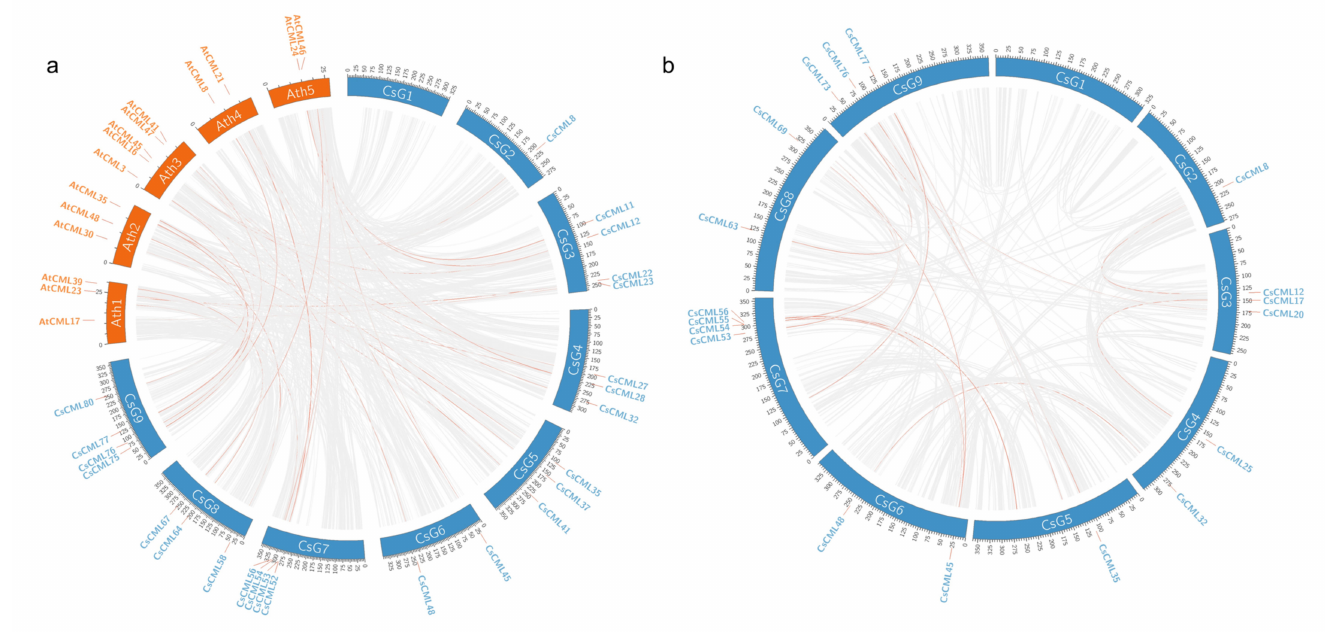
Figure 4. Collinearity analysis of CsCaM/CML genes. Circos plots displayed collinearity blocks between Arabidopsis thaliana and Chrysanthemum seticuspe ( a ) as well as within Chrysanthemum seticuspe ( b ). Links containing CsCaM/CML were colored with red; CaM/CML genes involved in collinearity blocks were